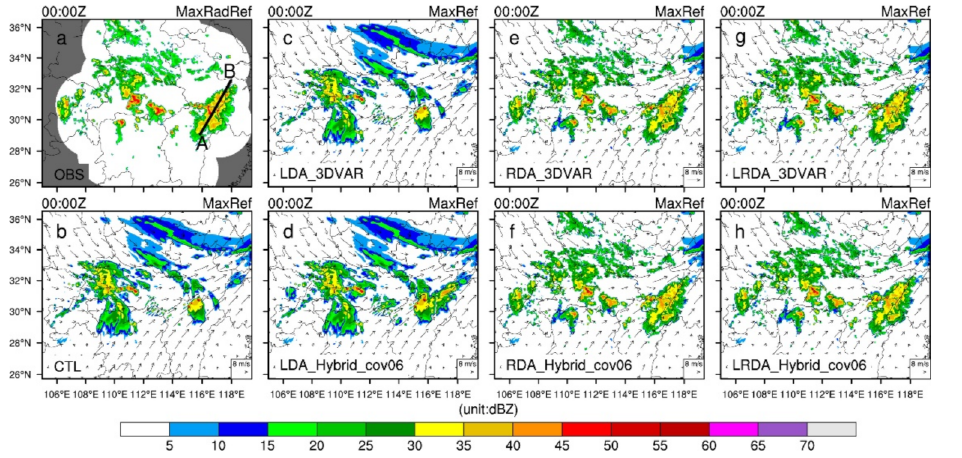
Figure 3. The observed maximum radar reflectivity (MaxRadRef) and analyzed maximum reflec- tivity (MaxRef) horizontal wind vectors at z = 4 km at 0000 UTC on 30 June 2018 (analysis time). ( a ) Observed maximum radar reflectivity interpolated onto the 3 km simulation domain, ( b ) control run (CTL), and for single-analysis experiments: ( c , d ) lightning data assimilation by 3DVAR and hybrid 3DEnVAR, ( e , f ) radar data assimilation by 3DVAR and hybrid 3DEnVAR, ( g , h ) and the com- bined lightning and radar data assimilation by 3DVAR and hybrid 3DEnVAR. The white background area is the range of radar scanning in ( a ). The black line AB in ( a ) denotes the locations of the vertical cross-sections for subsequent figures.